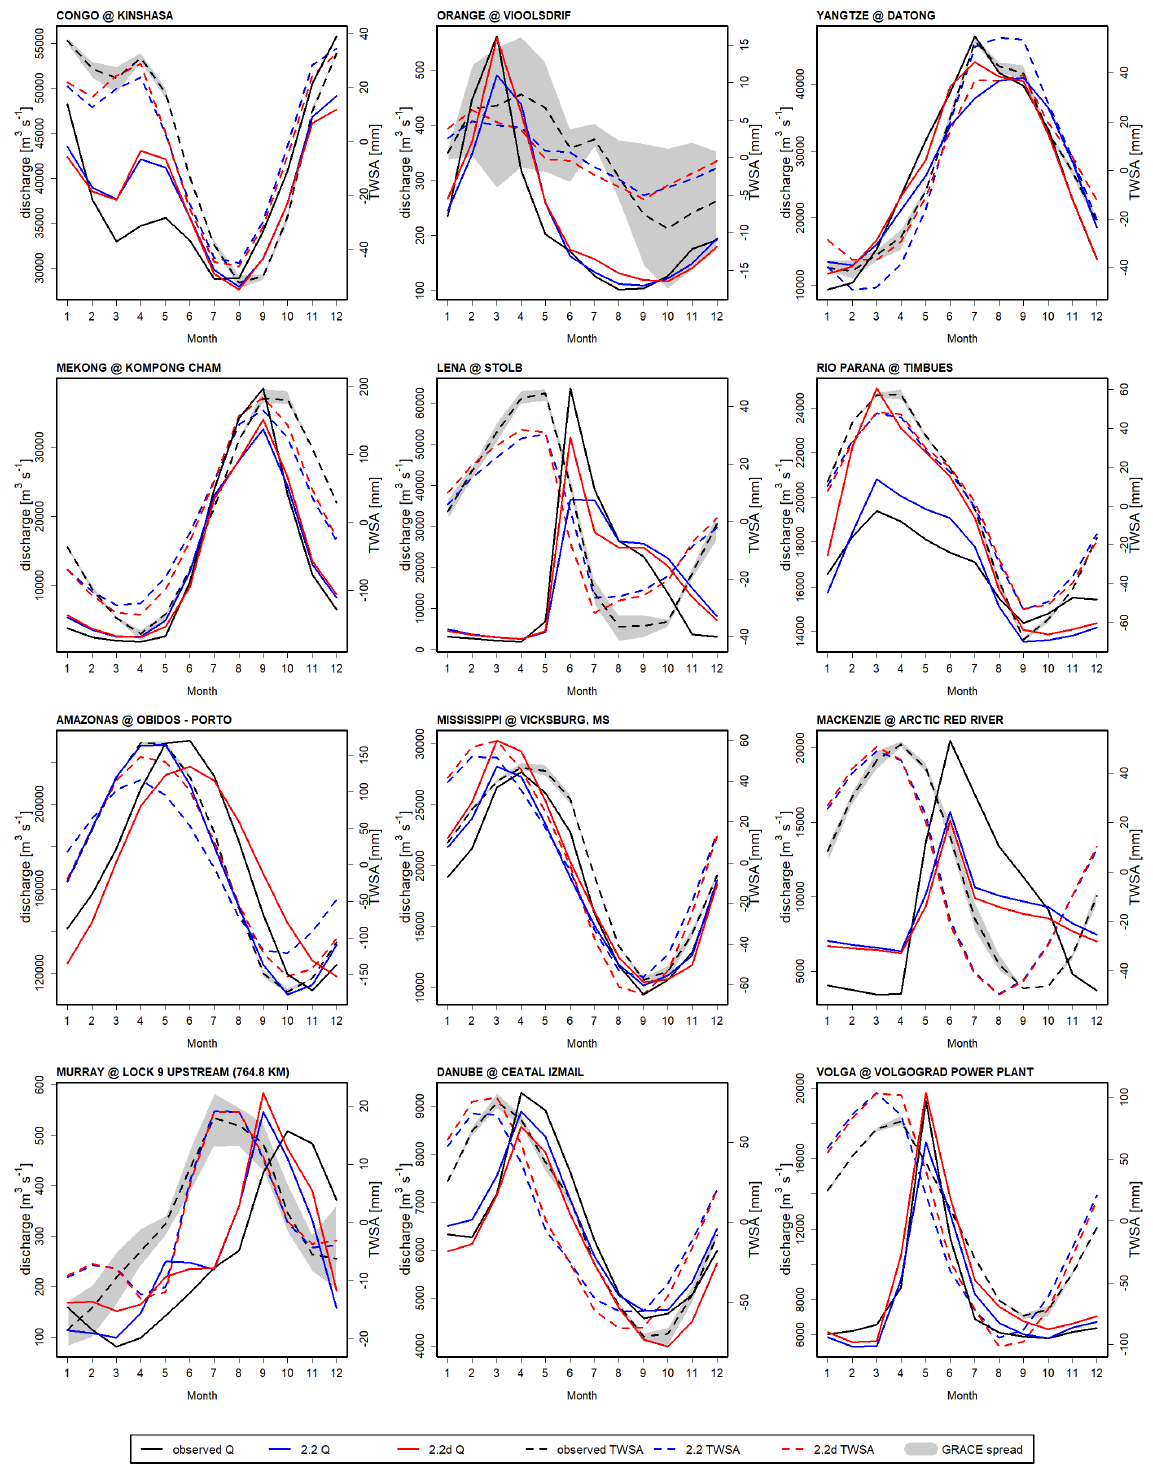
Figure 10. Seasonality of streamflow and TWSAs of selected large river basins: model results of WaterGAP 2.2d and WaterGAP 2.2 as well as streamflow and TWSA